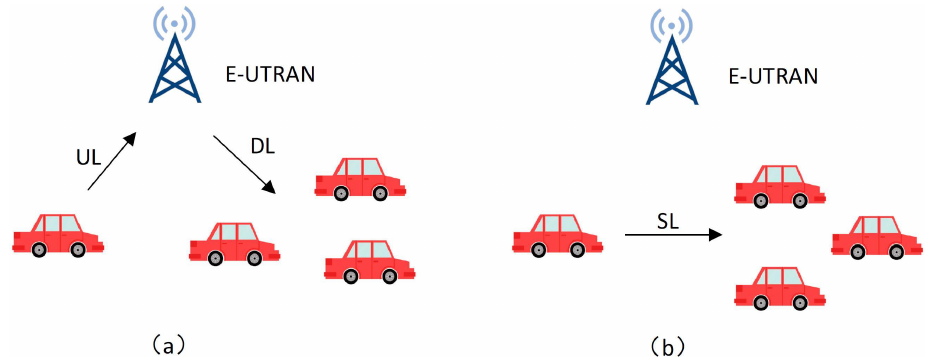
Figure 5. Two types of V2V connections: ( a ) from vehicles to vehicles with an intermediate transfer connection and; ( b ) directly from vehicles to other vehicles